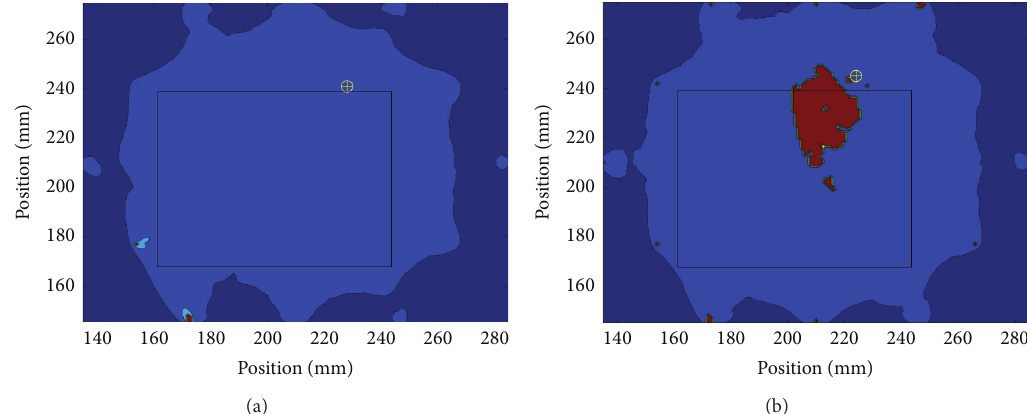
Figure 4: (a) SDC results with no damage progression factor (left) and (b) SDC results with damage progression factor of 1.10 (right) ∗ damage location indicated by yellow cross.